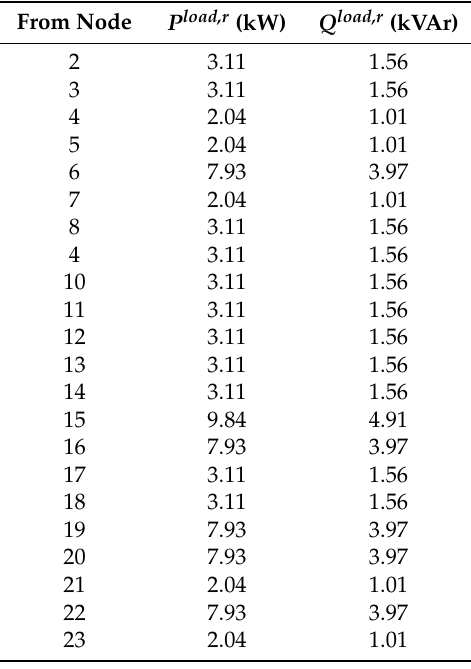
Table 2. Rated powers of uncontrolled loads.